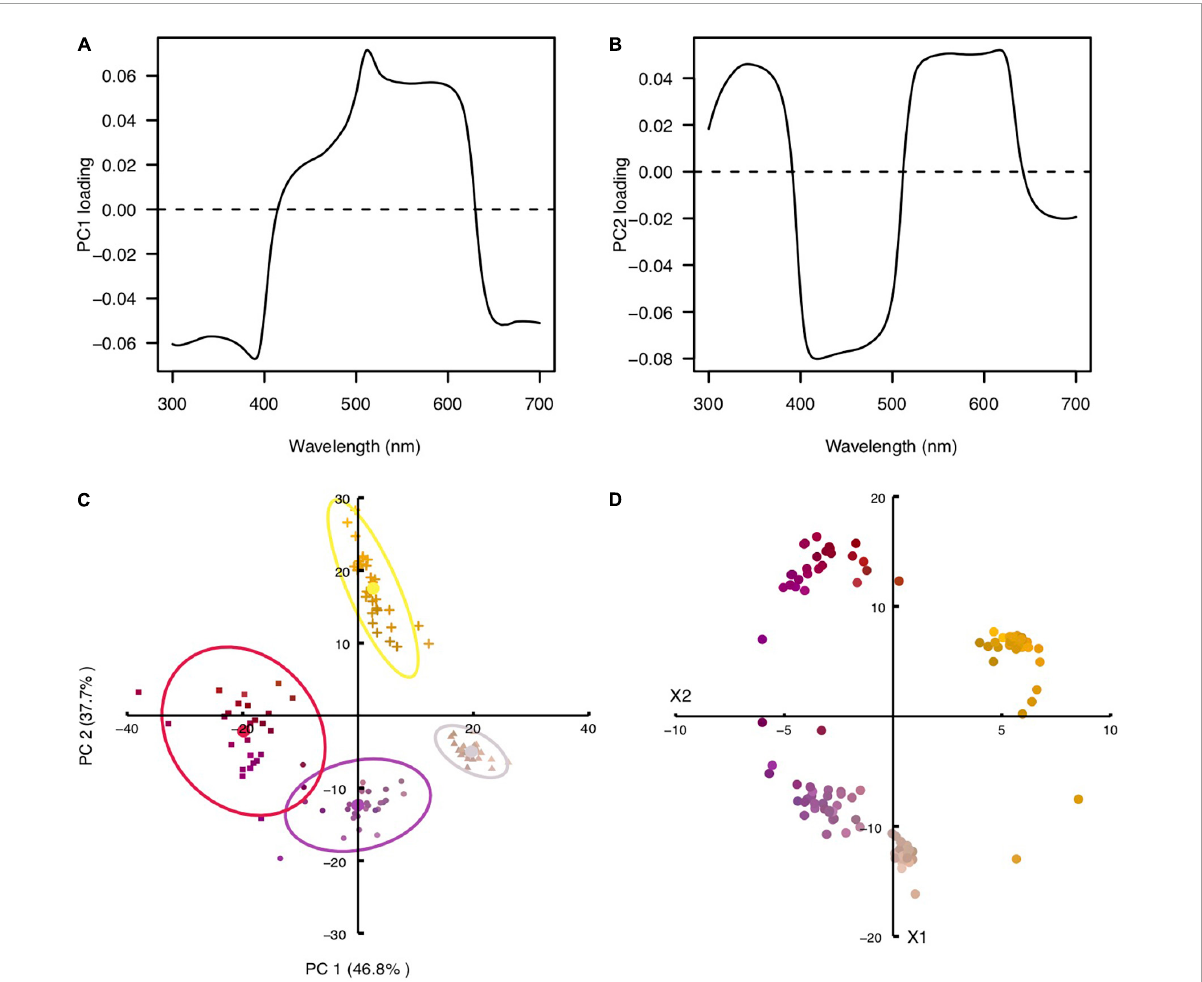
FIGURE3 Principal component and chromaticity analysis of Cistanthe longiscapa flowers. (A) Principal component 1 as a function of wavelength, which accounted for 47% of the total variance in flower color. (B) Principal component 2 as a function of wavelength, which accounted for 38% of the total variance in flower color. (C) Clusters of flowers in the PCA diagram. (D) Clusters of flowers in the chromaticity diagram. The colors of the symbols in (C , D) resemble the colors of the flowers as seen by